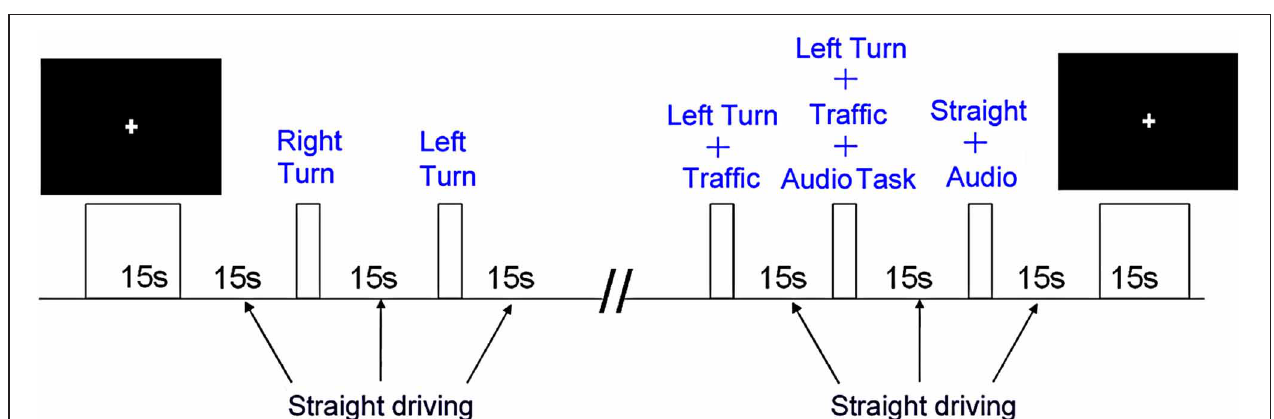
FIGURE 1 | Representative STISIM screenshots of simulated driving conditions used in the fMRI. Rural scenery was chosen to minimize the potential confounding variations